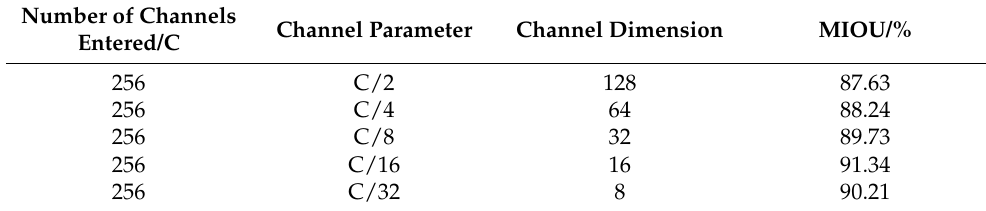
Table 3. MIOU under different channel numbers.